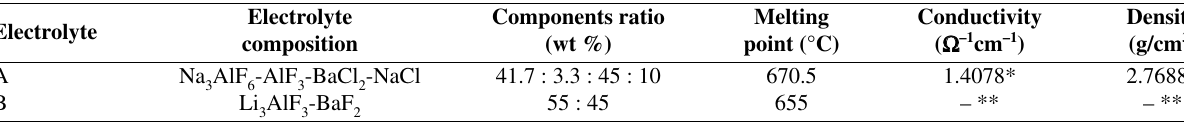
Table 2. Composition and selected properties of electrolyte A and B. Electrolyte